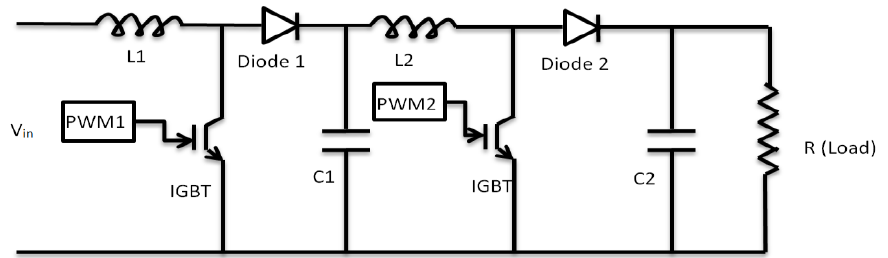
Figure 10. The circuit diagram of a double-stage boost converter.